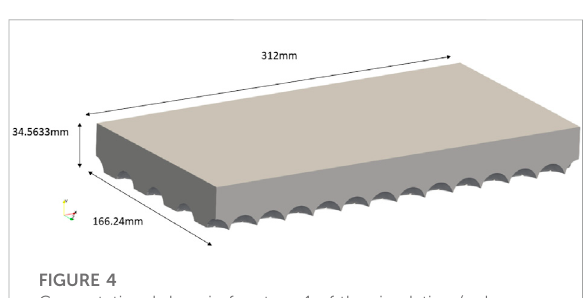
FIGURE 4 Computational domain for stage 1 of the simulation (only 4 spherical cap roughness elements are